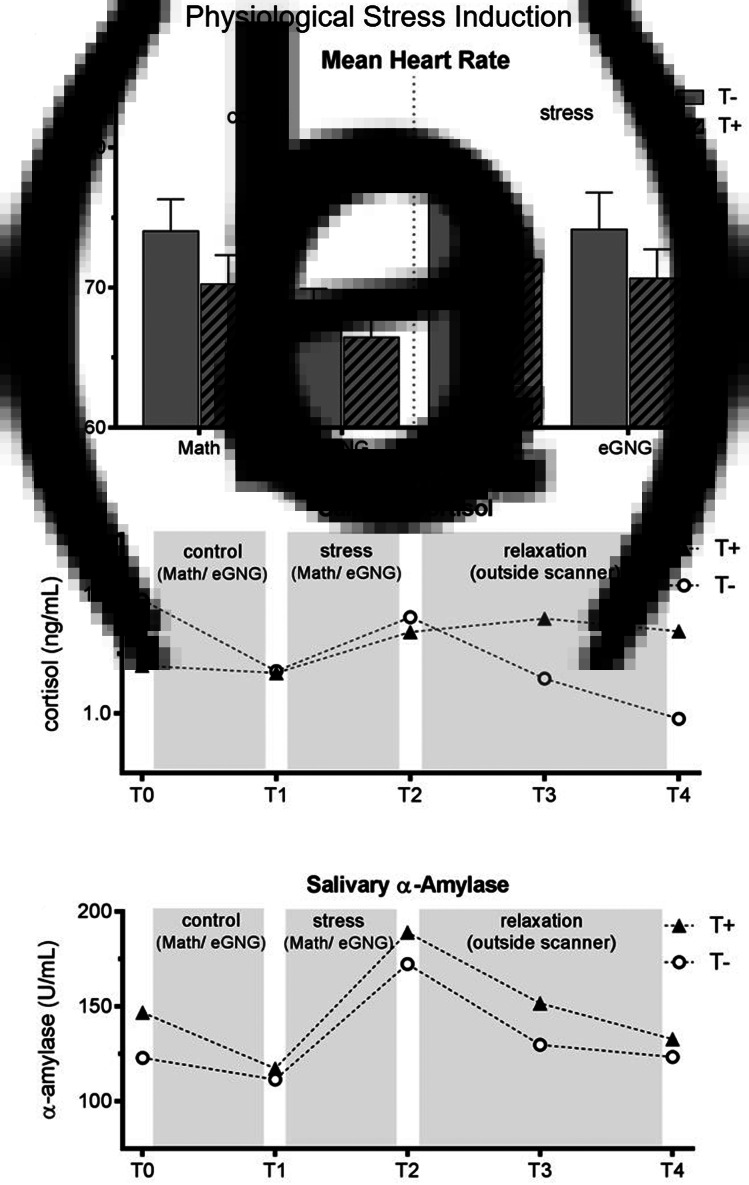
(a) Mean heart rate over the experiment. Heart rate data of eight participants (3 T+ and 5 T−) had to be excluded due to scanner and movement related artefacts. We computed a mixed ANOVA including condition (control v. stress) and task (MIST v. eGNG) as within-subject factors and group as a between-subject factor. A significant main effect of condition (N = 38, F1,37 = 13.8, p = 0.001) demonstrated elevated heart rate in the stress condition compared to control, while a main effect of task (N = 38, F1,37 = 61.8, p < 0.001) indicated higher mean heart rate during presentation of math questions than during the eGNG paradigm. There was no main effect of group and no significant interactions. (b) Raw salivary cortisol data. Before the analysis of salivary cortisol and salivary α-amylase levels, one participant (T−) had to be discarded due to food consumption at sampling time. For statistical analysis, data were winsorized and log-transformed. Two mixed ANOVAs including a within-subject factor time (5 measurement points) and a between-subject factor group were conducted. For cortisol, we found a main effect of time (N = 45, F4,43 = 4.8, p = 0.009), but no main effect of group or interaction effect. Post-hoc Bonferroni corrected paired samples t tests examining the increase during stress condition (T1 v. T2) and subsequent recovery (T2 v. T3) across all participants showed a significant cortisol increase during stress (T1 v. T2: N = 45, t44 = 2.4, p = 0.044 adjusted) and recovery afterwards (T2 v. T3: N = 45, t44 = 5.2, p = < 0.001 adjusted). (c) For α-amylase, there was a main effect of time (N = 45, F = 4172 = 17.3, p < 0.001), no main effect of group, but a time by group interaction (N = 45, F4172 = 2.6, p = 0.037). To decode the interaction, we conducted Bonferroni corrected paired sample t tests between all consecutive time points (T1 v. T2, T2 v. T3, etc.) for both groups separately (four tests per group). This analysis revealed a marginally significant salivary α-amylase decrease from T0 to T1 in T+ participants (N = 23, t22 = 2.7, p = 0.056 adjusted) but not in T− participants (p > 0.999 adjusted), as well as large increases from T1 to T2 in both groups (T+ group: N = 23, t22 = 7.4, p < 0.001 adjusted, d = 1.6; T− group: N = 22, t21 = 3.8, p = 0.004 adjusted, d = 0.9). There were no significant differences in any other paired tests. Thus, the interaction was attributable to group differences in α-amylase changes from T0 to T1, resulting from higher α-amylase baseline levels (T0) in the T+ group (two-sample t test of T0 values: N = 45, t44 = 2. 2, p = 0.030). See online Supplementary Table S3 for all means and standard errors. T−, trauma-naïve control participants; T+, trauma-exposed participants; control, control condition; stress, stress condition; eGNG, emotional go-nogo paradigm; bpm, beats per minute.